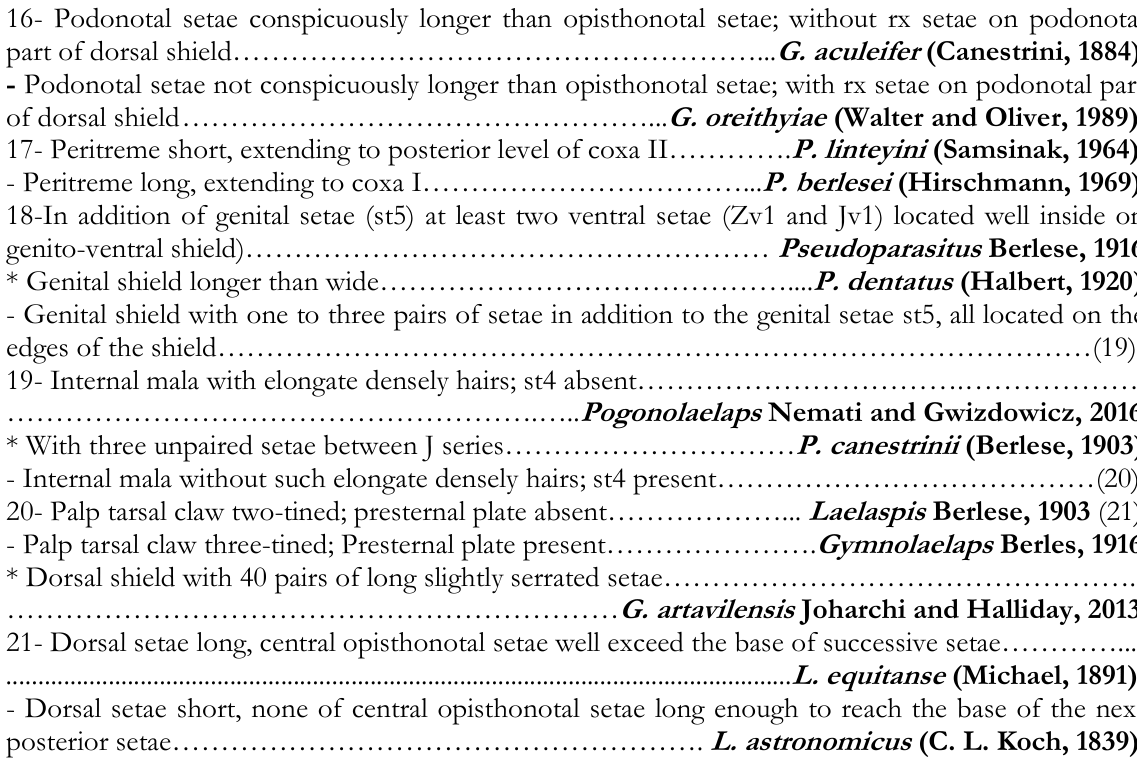
17- Peritreme short, extending to posterior level of coxa II…………. P. linteyini (Samsinak, 1964) 18-In addition of genital setae (st5) at least two ventral setae (Zv1 and Jv1) located well inside on - Genital shield with one to three pairs of setae in addition to the genital setae st5, all located on the